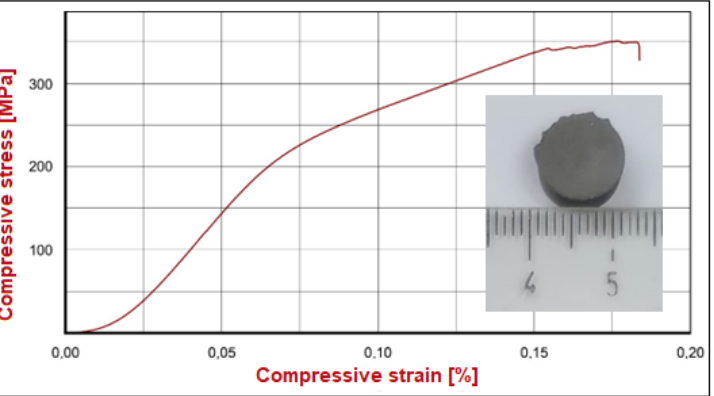
Figure 12. Stress-strain curve after compressive testing applied on the Mg-10Zn-0.8Ca-0.5Zr alloy processed by